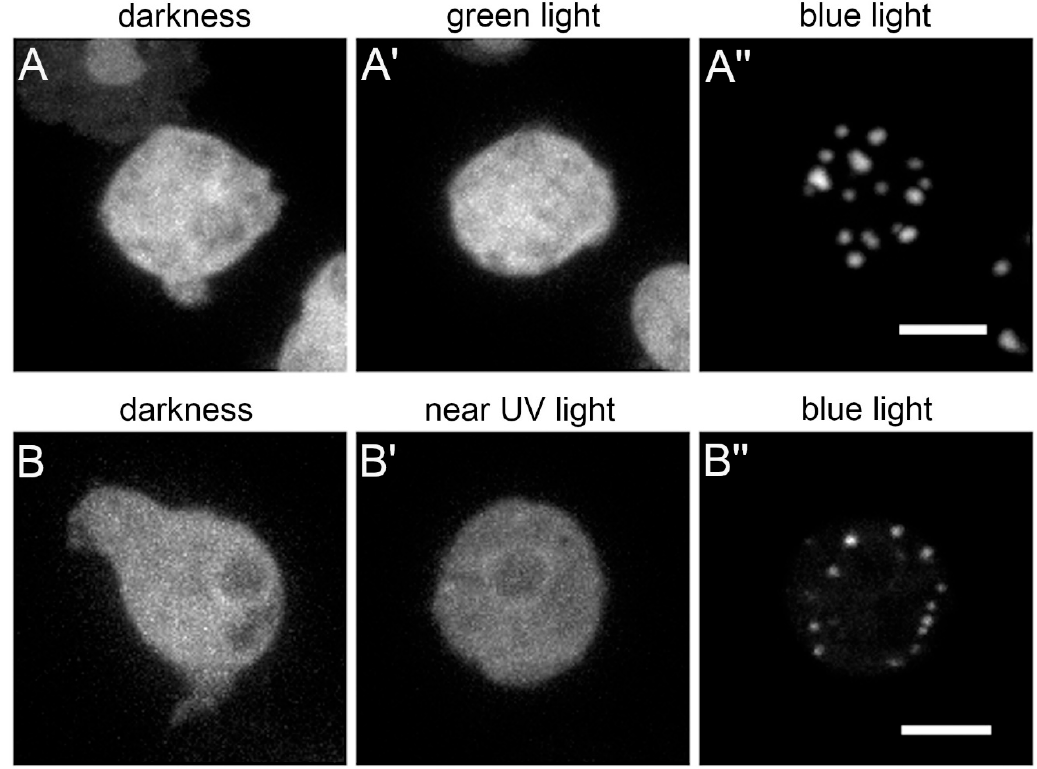
Figure 2. Assembly of GFP-NE81-S122E Δ NLS Δ CLIM is wavelength-dependent and occurs only upon blue, but not green or near UV light exposure. ( A , B ) Selected time points of live cell confocal spinning disk microscopy series comparing response to green light (561 nm) ( A ) or near UV light (405 nm) (B) versus blue light (488 nm). The same representative cell is shown in ( A – A’’ ) and ( B – B’’ ), respectively; the left cell shows the situation at t = 0 (recording of one image stack at 8% AOTF transmission). Laser excitations to trigger assembly in ( A’ , A’’ , B’ , B’’ ) were for 3 min at 40% AOTF transmission. Maximum intensity projections of fifteen focal planes at a distance of 0.27 µm are shown. Scale bars = 5 µm.